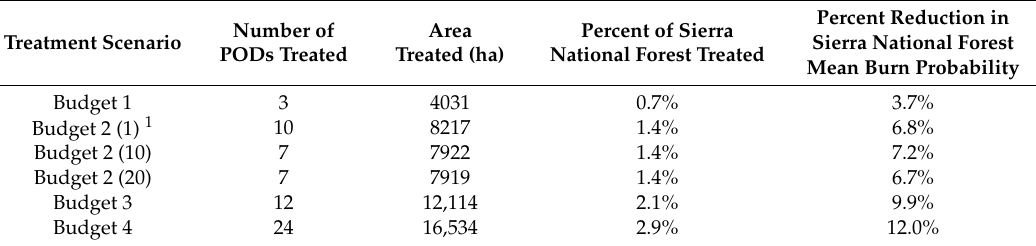
Table 1. Summary of fuel treatment scenarios.